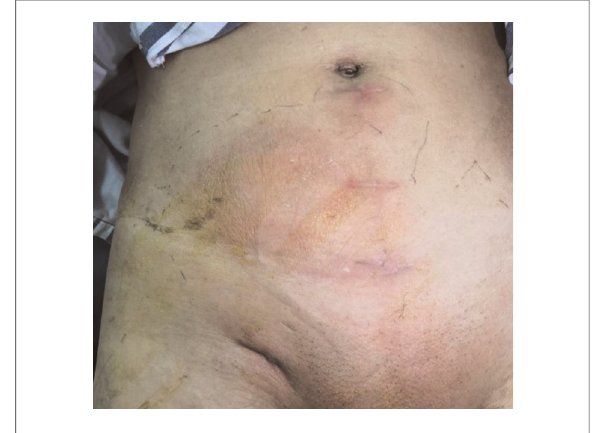
FIGURE 3 A patient with local swelling, erythema and fever after right inguinal hernia repair (TAPP) 2 weeks